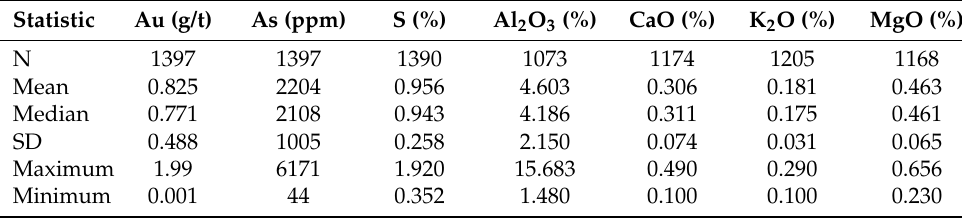
Table 2. Summary statistics of variables analysed.